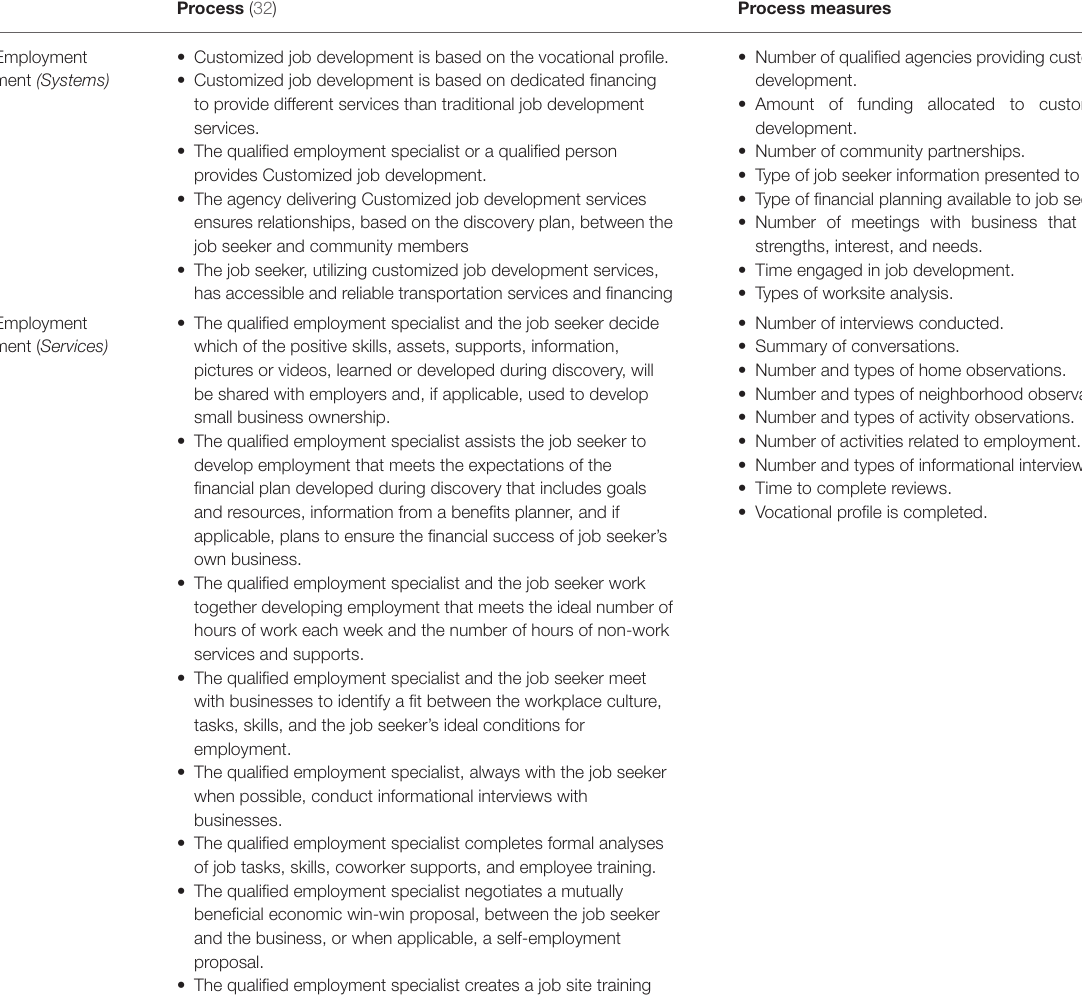
TABLE 2 | Process, process measures, and proximal and distal outcomes for CE job development.